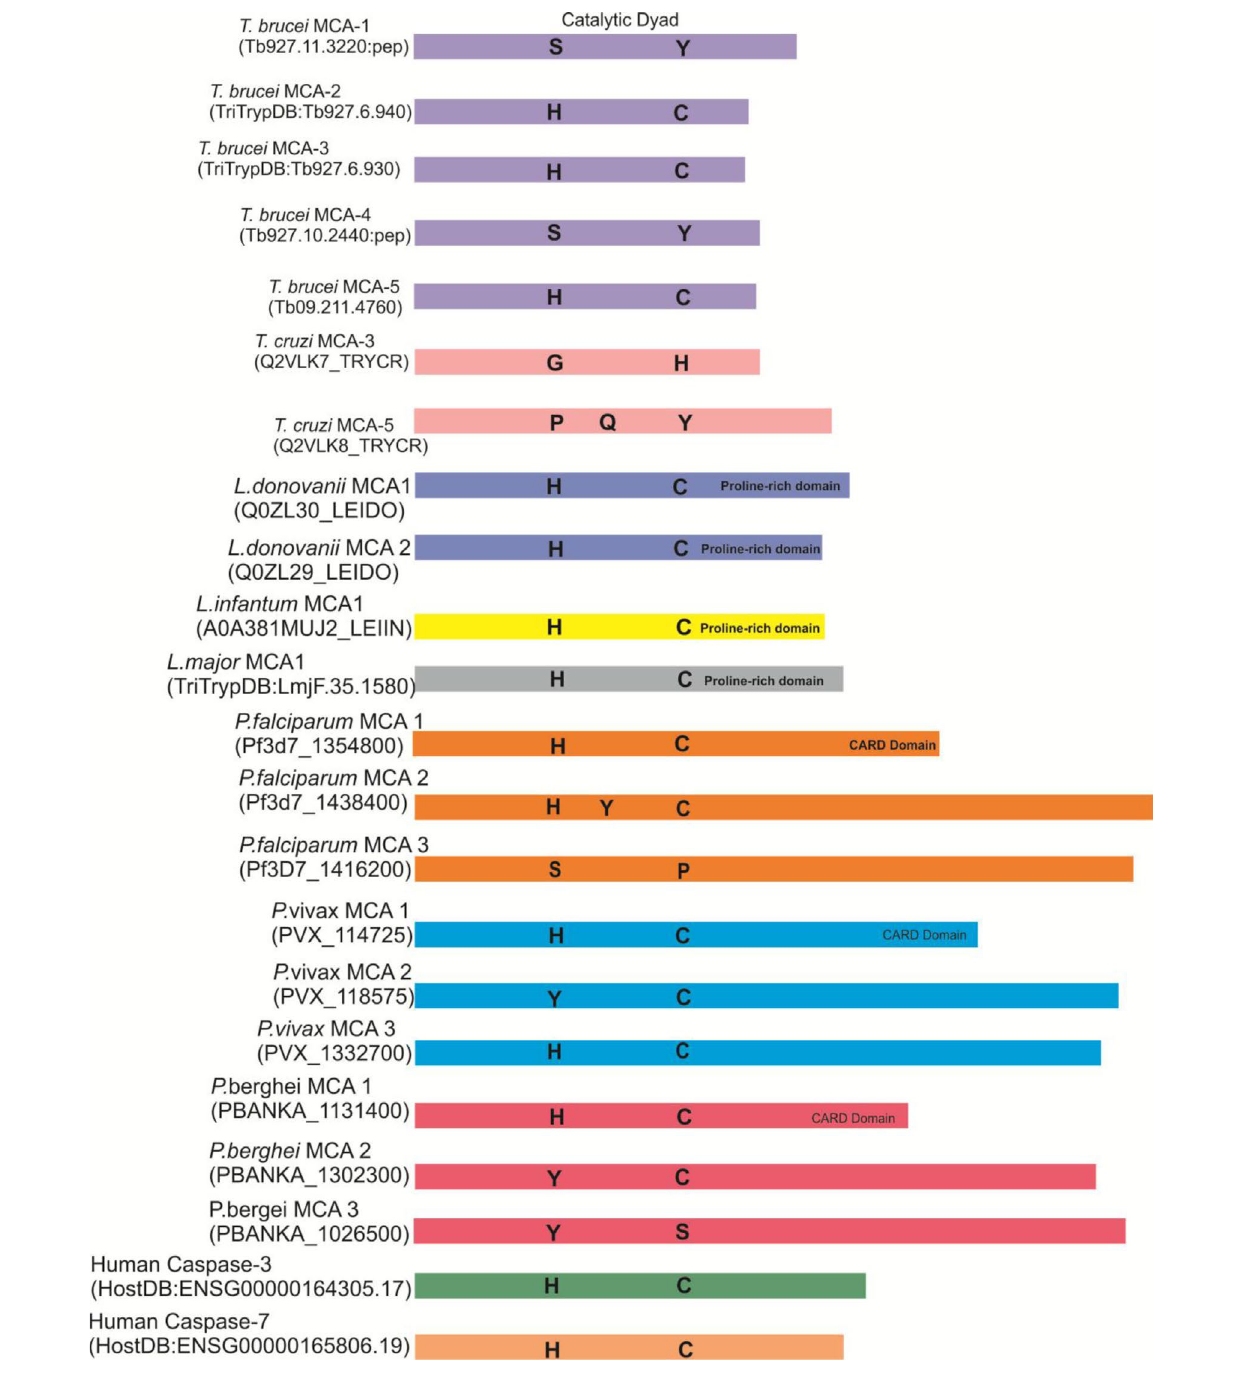
FIGURE 2 | Representation of the relative sizes and the predicted catalytic residues of metacaspases from protozoan and human caspases 3 and 7. In Tb MCA-1 and 4, catalytic dyad His/Cys were subjected to be replaced by Ser/Tyr, respectively. Similarly, in Pf MCA-3, His/Cys catalytic dyad is replaced by ser/pro